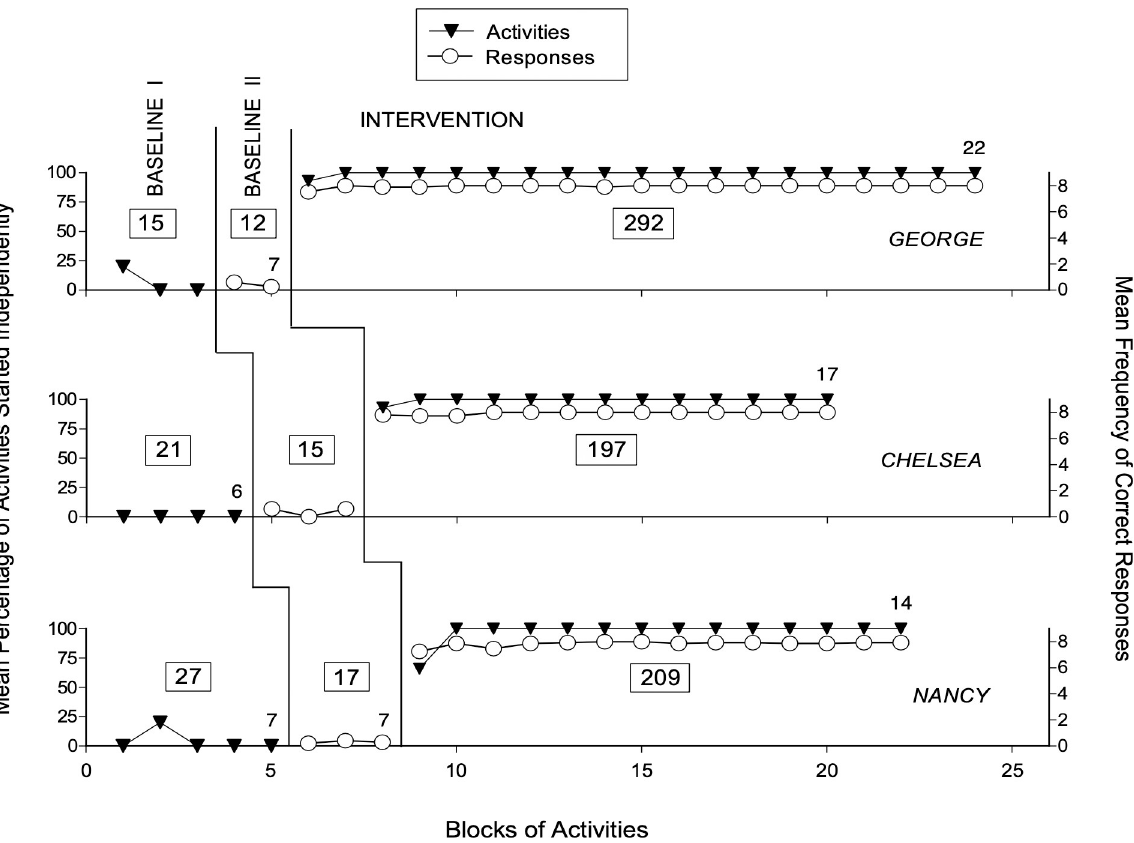
Fig 2. The three panels report the data for George, Chelsea, and Nancy, respectively. Data are plotted as in Fig